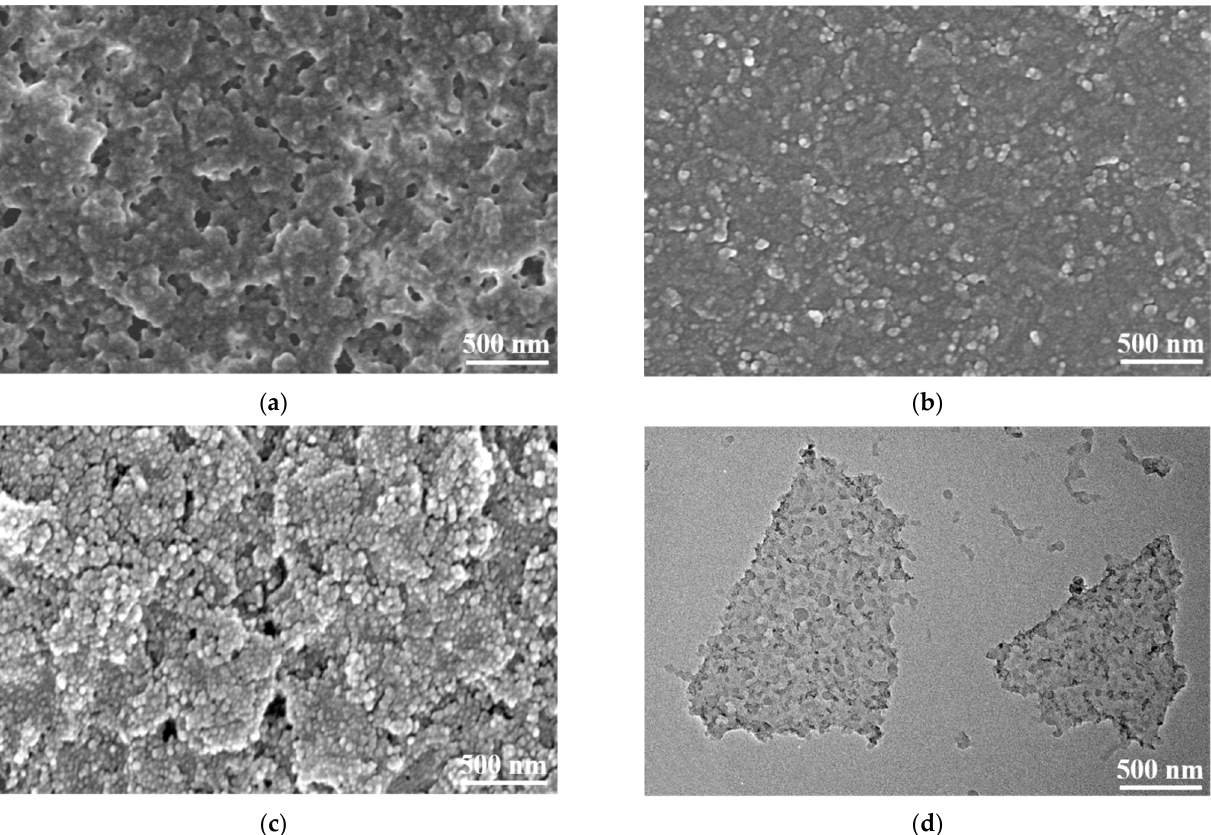
Figure 3. ( a ) SEM images of the spray-coated MXene film; ( b ) The SEM images of PAN film; ( c ) SEM images of the spray-coated PANI/MXene film; ( d ) TEM morphology of the PANI/MXene film.